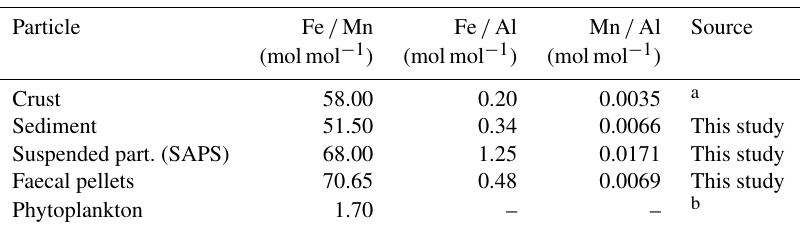
Figure 2. (a) OTE seawater samples: distribution of leachable particulate iron (LP Un Fe in black), manganese (LP Un Mn in blue), and alu- minium (LP Un Al in red) concentrations in the water column of stations located on the island shelf (125–270m water depth). SAPS samples: the particulate Fe (PFe) fraction retrieved by SAPS is illustrated with open black circles and corresponds to the same axis as LP Un Fe. Concentrations above 120nmolL − 1 are listed in Tables 1 and 2. Error bars represent the standard deviation of the analysis. Density ( σ θ ) in kilograms per cubic metre is illustrated by the black dashed line. (b) OTE seawater samples: dissolved iron (DFe), manganese (DMn), and aluminium (DAl) are represented by the same colour code as above. Dashed lines illustrate Chlorophyll a (Chl a ) content of the water column recorded by the CTD fluorometer. Table 3. The different elemental ratios of the Earth’s crust, sediment, suspended particles (SAPS), faecal pellets, and biogenic particles (average phytoplankton